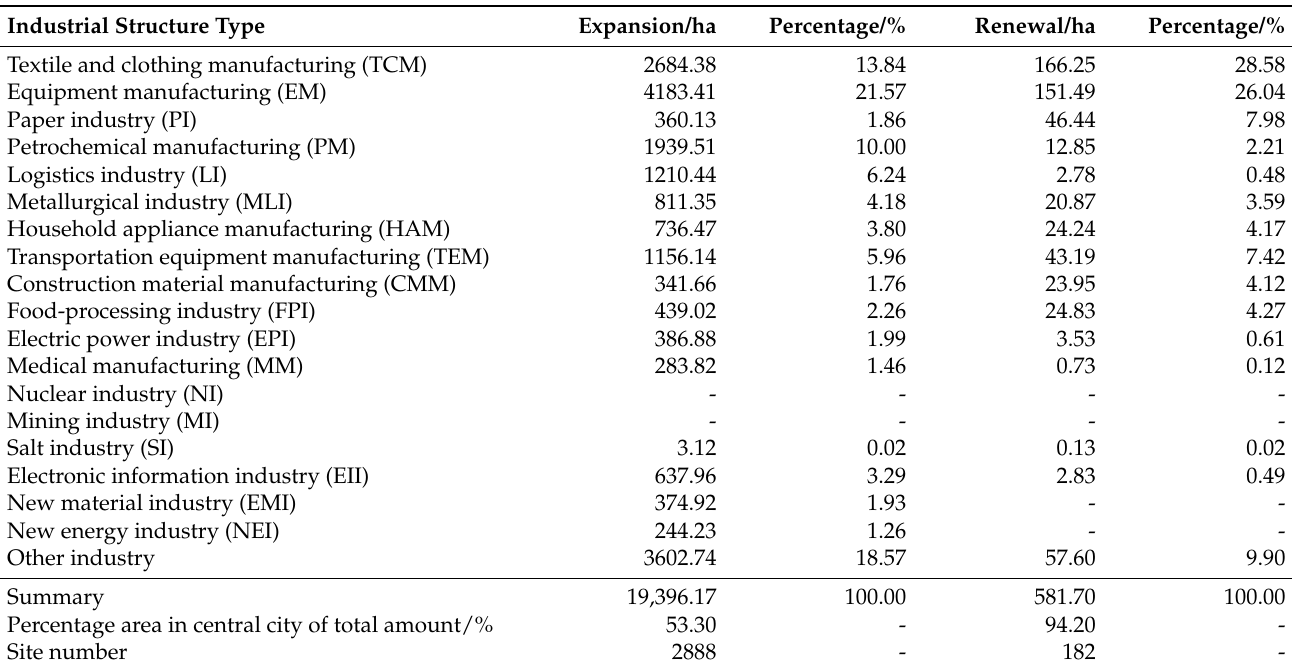
Table 4. Industrial land-use proportions of expansion (renewal) projects during